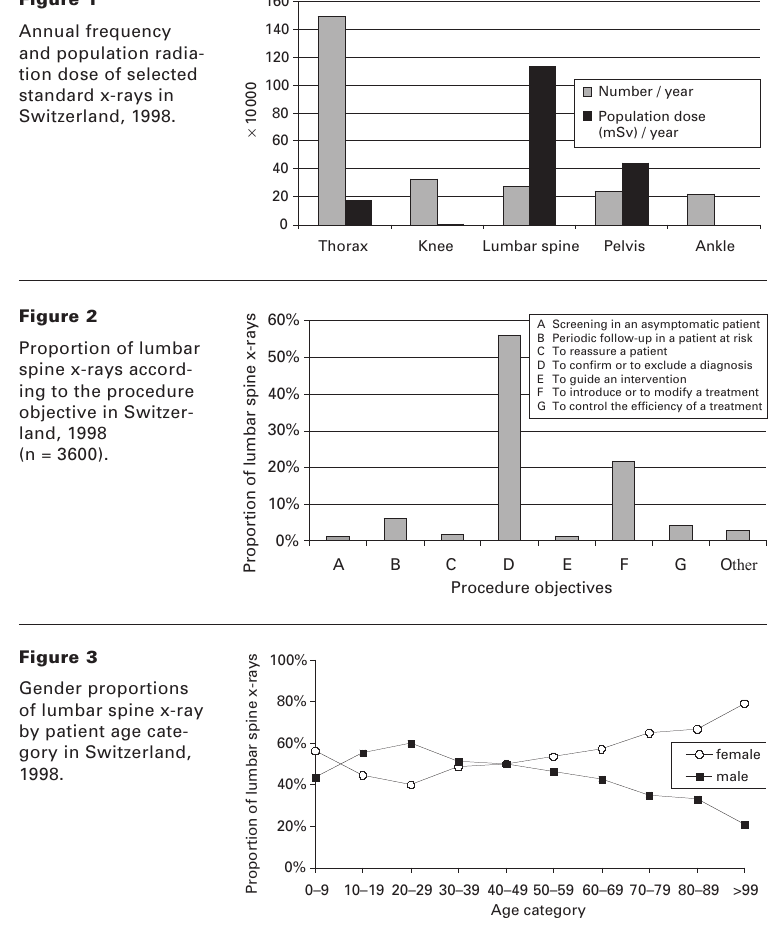
Annual frequency and population radia- tion dose of selected standard x-rays in Switzerland, 1998.